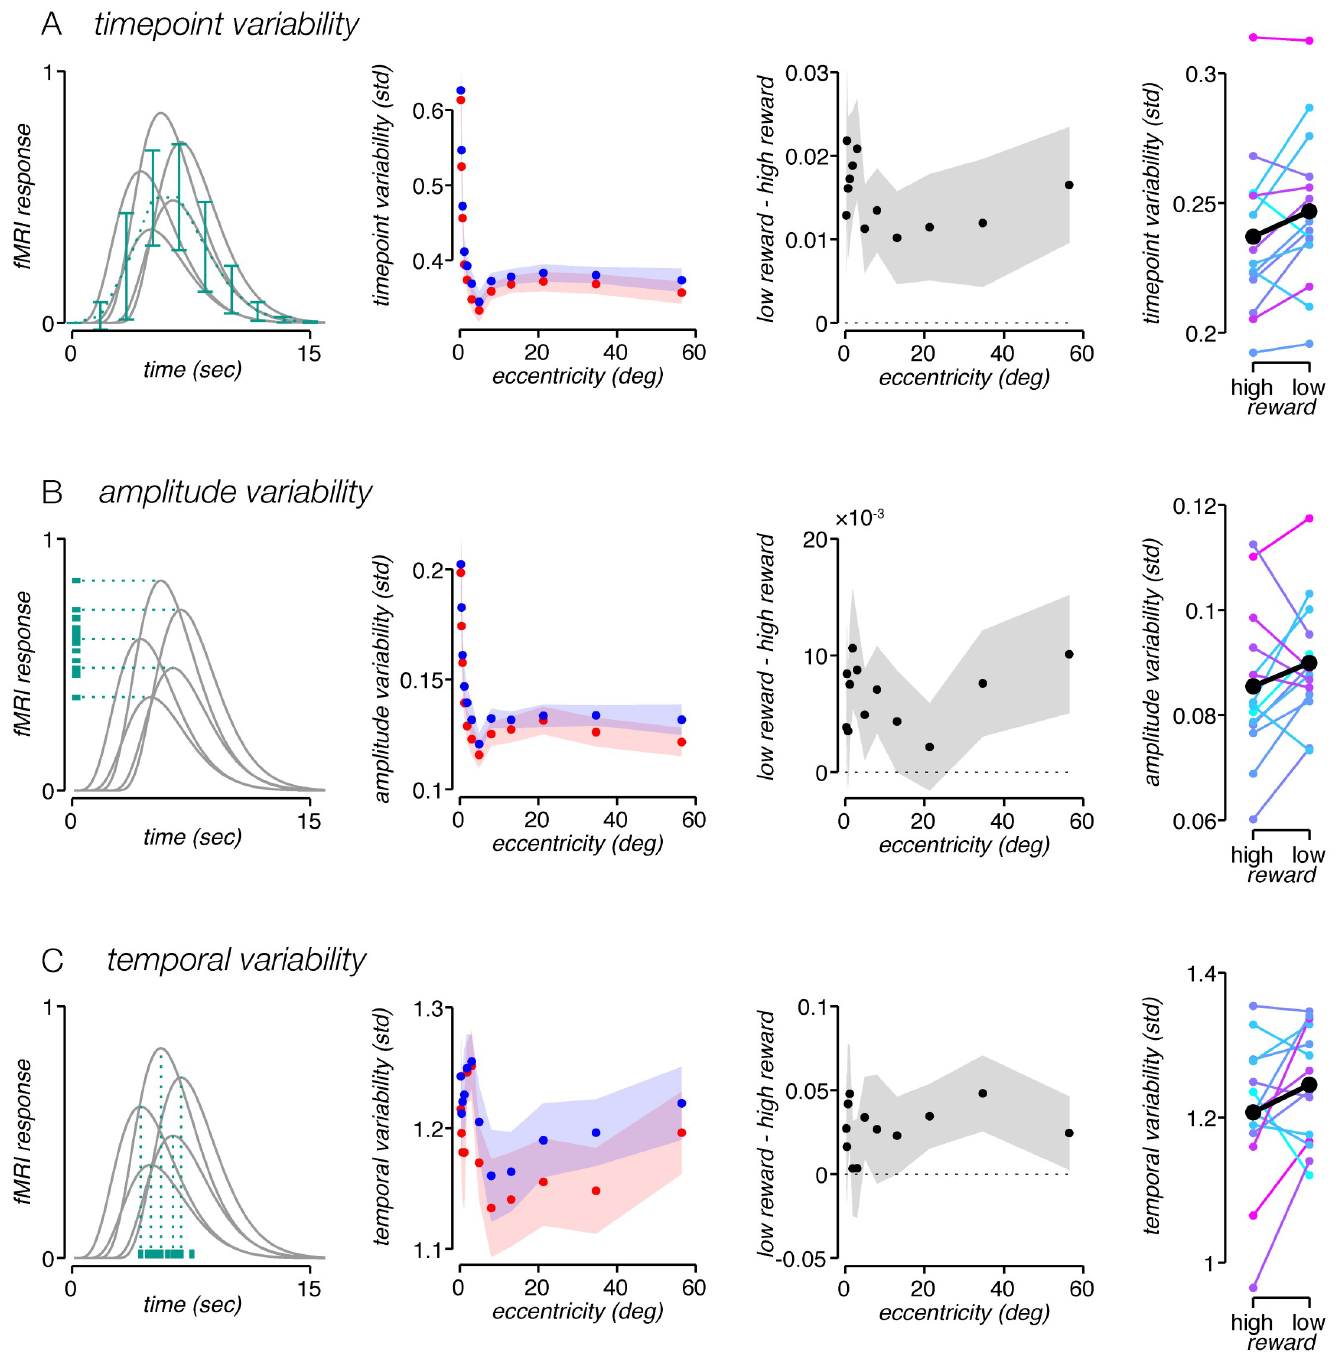
Fig 5. Higher reward decreases three measures of response variability. (A) Time-point variability of task-related response. Leftmost panel, schematic illustration of analysis. Gray lines, simulated task-related responses; green dotted line, mean response; green error bars, std at each time point. Time-point variability was quantified by taking the std of each time point in the task-related response, averaging across time points, and then averaging across participants. Second panel, time-point variability as function of eccentricity, for high (red) and low (blue) reward. Third panel, high-reward time-point variability subtracted from low-reward time-point variability as function of eccentricity. Shaded regions, ± SEM across participants. Rightmost panel, mean time-point variability of EVC task-related response, for all participants. Time- point variability was significantly lower for high- than for low-reward trials. Data points and lines connecting high- and low-reward variabilities in all right panels are colored, as in Fig 4C, according to the difference between high- and low-reward response amplitude for each participant. (B) Leftmost panel, schematic illustration of analysis. Green horizontal lines, amplitudes of simulated responses. Amplitude variability was quantified by first computing the amplitude (i.e., std) of each trial, then